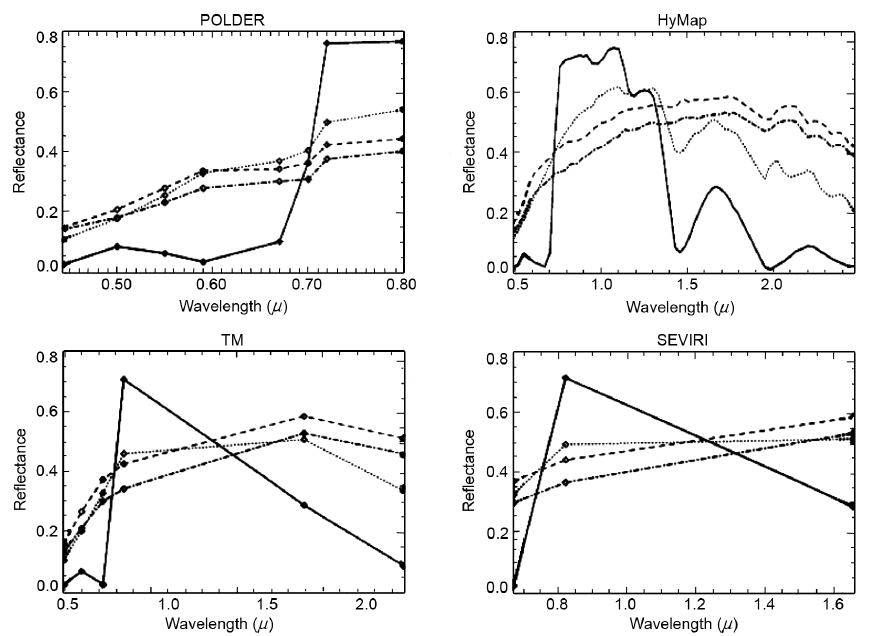
Fig. 1. Spectral inputs introduced to DISMA, which correspond to leaf albedo of green (solid) and dry vegeta- tion (dotted), and reflectance of two different